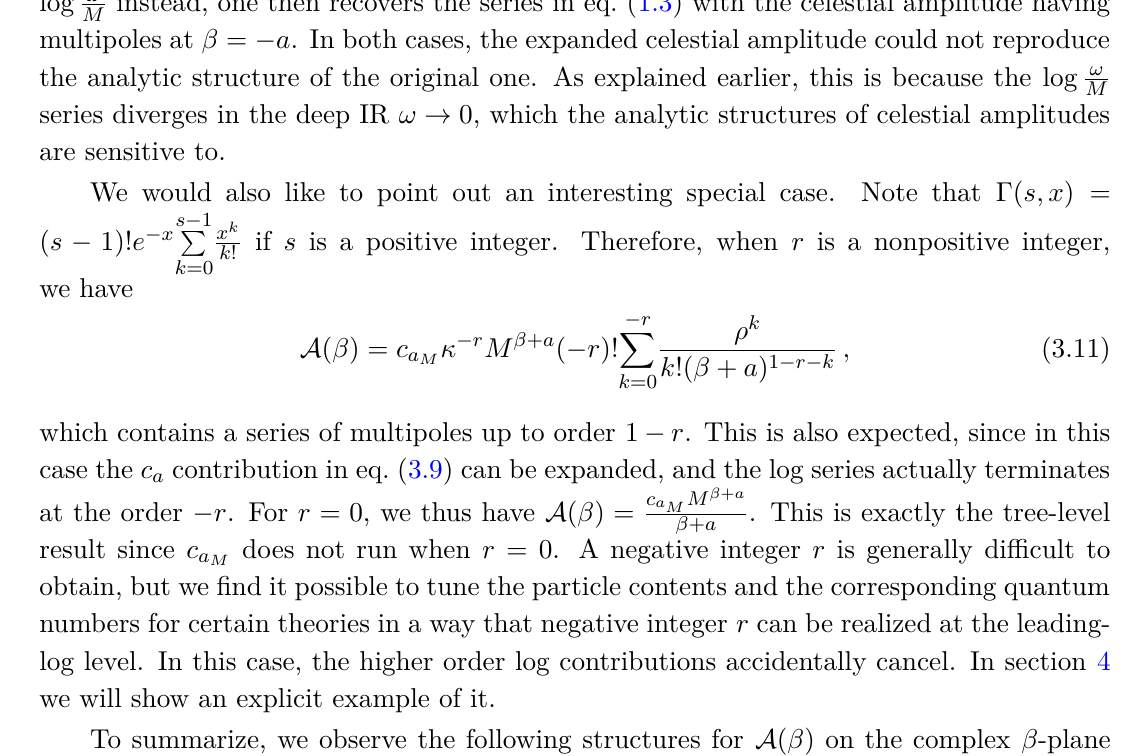
, where for clarity we show the case with negative γ c